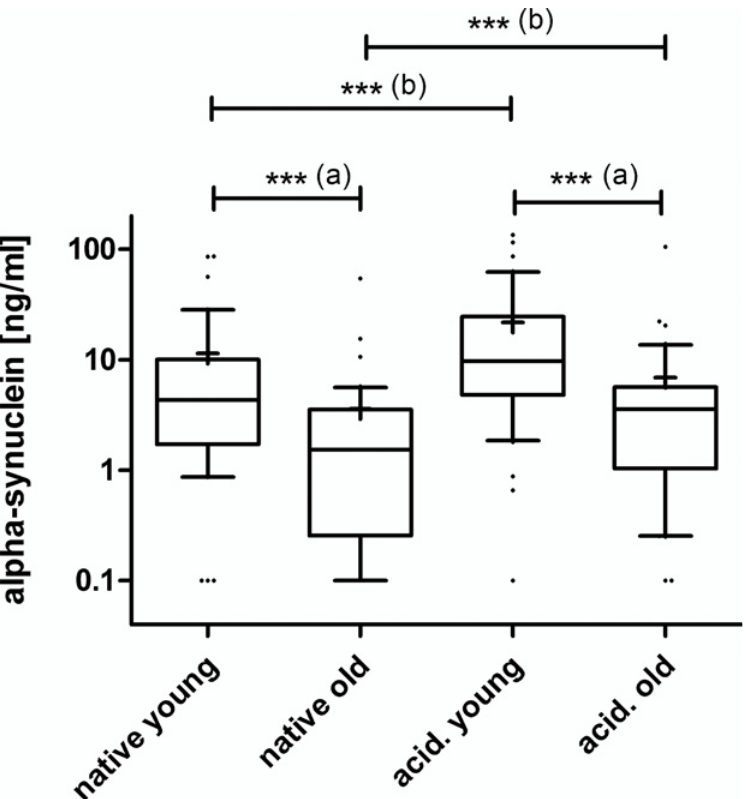
Fig 7. Box plots * of alpha-synuclein levels in native and acidified plasma. (a) Younger in comparison to older individuals revealed higher alpha-synuclein levels, highly significant by Mann Whitney test for native, p = 0,0005 and acidified plasmas, p < 0.0001. (b) Plasma acidification increased alpha-synuclein concentrations in both age groups, highly significant by a one-tailed Wilcoxon matched pairs test, p < 0.0001. The additional horizontal short line in the box represents the